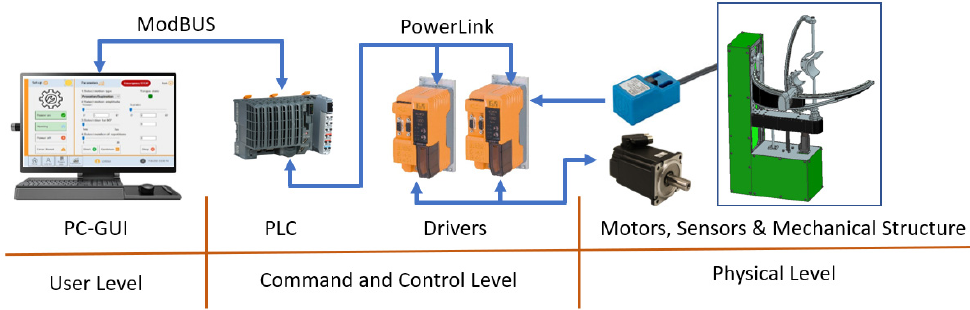
Figure 10. Hardware configuration of the ASPIRE robot control system.